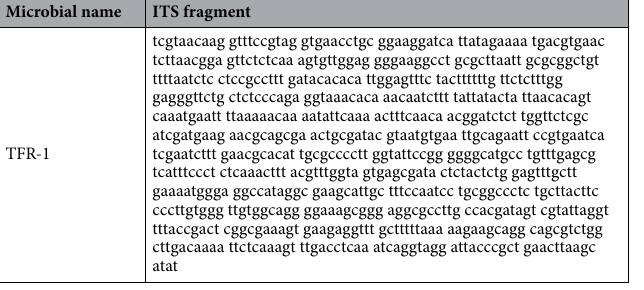
Table 2. ITS fragment from